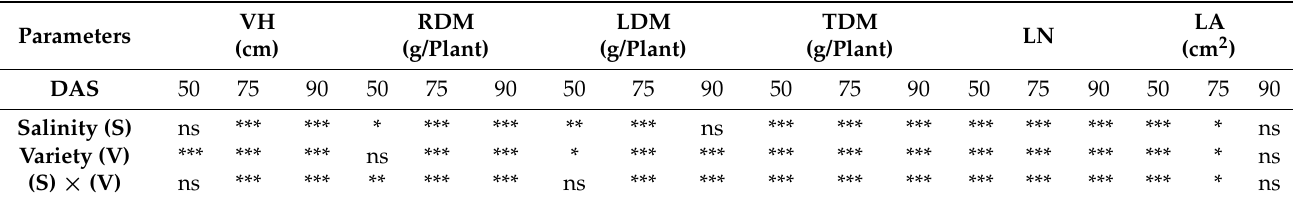
Table 1. Variation of agronomic parameters during the quinoa growth cycle.